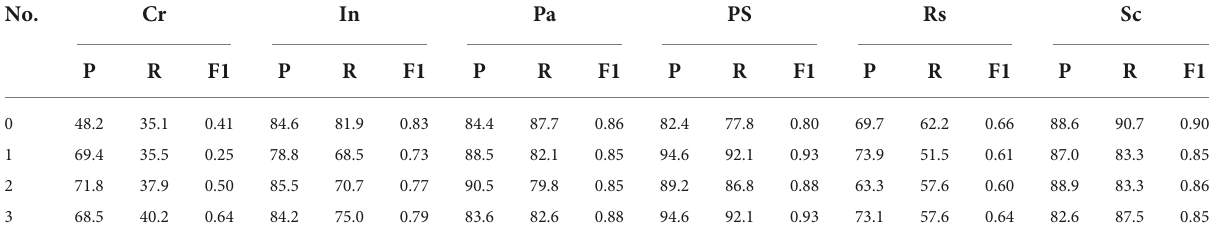
TABLE 2 Comparison of P, R, and F1 for different improvements of YOLOX.